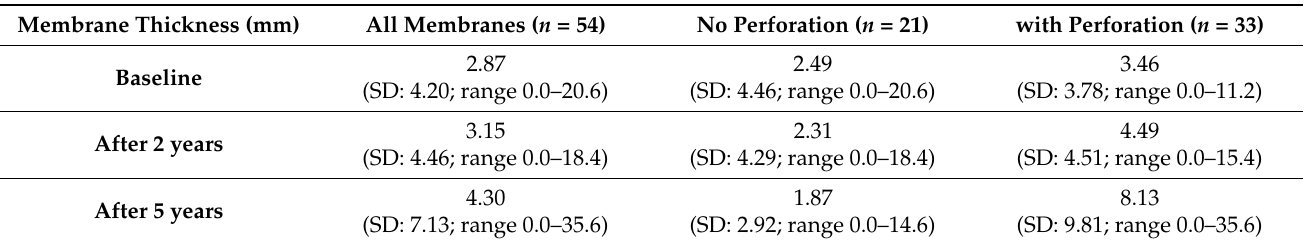
Table 1. Mean thickness (mm) of Schneiderian membrane after 2 and 5 years is presented either with or without MDI perforation.